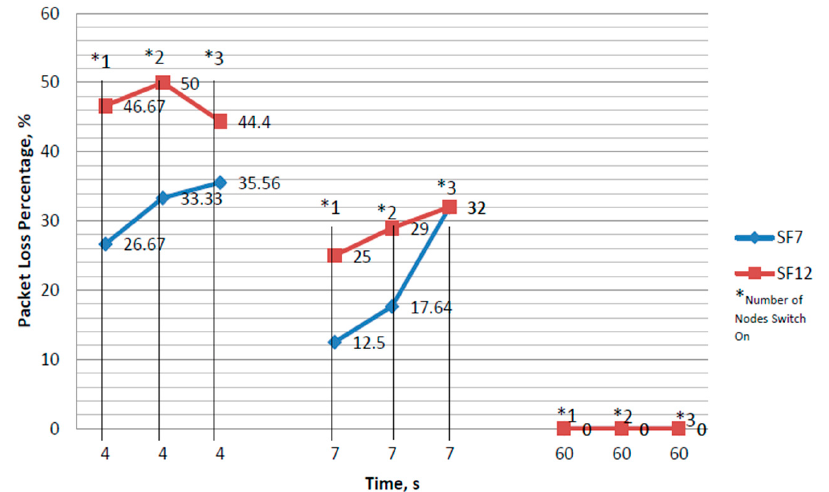
Figure 13. The percentage of packet loss during data transmission between the LoRaWAN ® GW and EN.